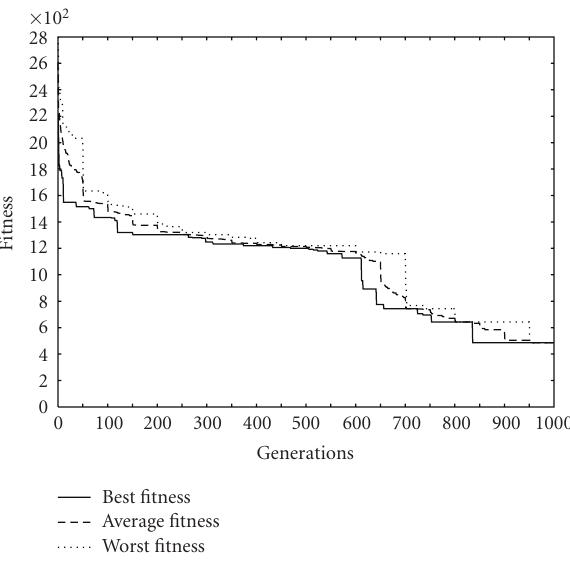
Figure 4: Behavior of fitness as a function of the number of generations for the best run of experiment